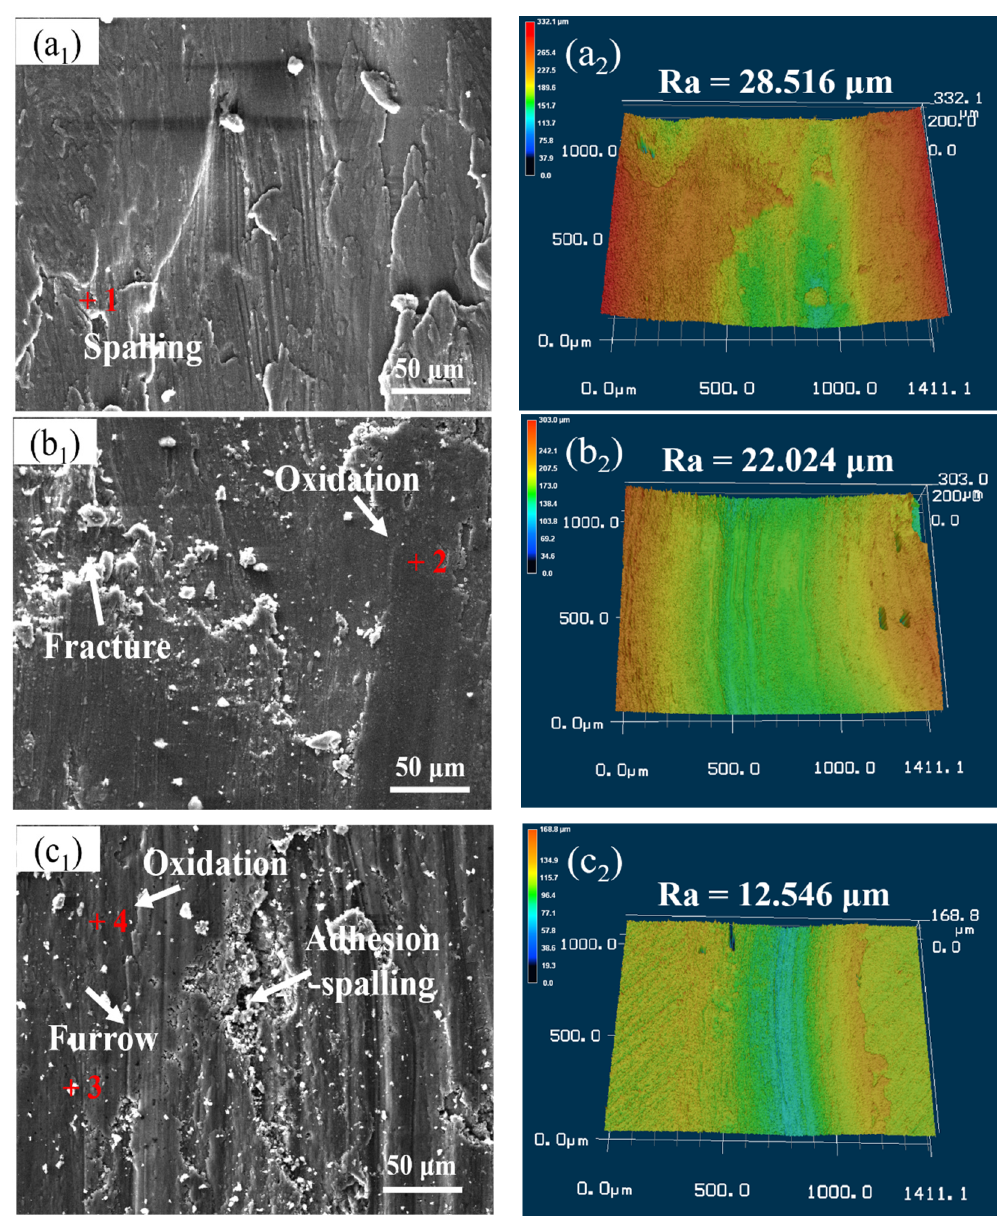
Figure 8. Worn surface analysis of samples after wear test at 200 °C. ( a1 ) worn surface of Al 7075; ( a2 ) 3D laser scanning topography of Al 7075; ( b1 ) worn surface of 15 wt.% VN/7075; ( b2 ) 3D laser scanning topography of 15 wt.% VN/7075; ( c1 ) worn surface of 20 wt.% TiB2-TiCx/7075; ( c2 ) 3D laser scanning topography of 20 wt.% TiB 2 -TiC x /7075. Table 5. EDS results (wt.%) in regions 1–4 indicated in Figure